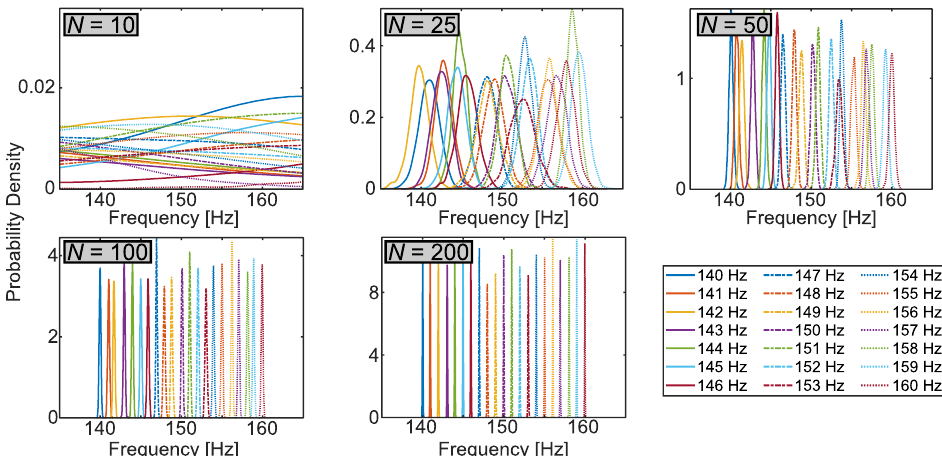
Figure 5. Marginal posterior distributions of excitation frequency, obtained by Bayesian inference of the datasets in Figure 4 and grouped by the number of data samples N . The ground truth frequencies for each curve appear in the